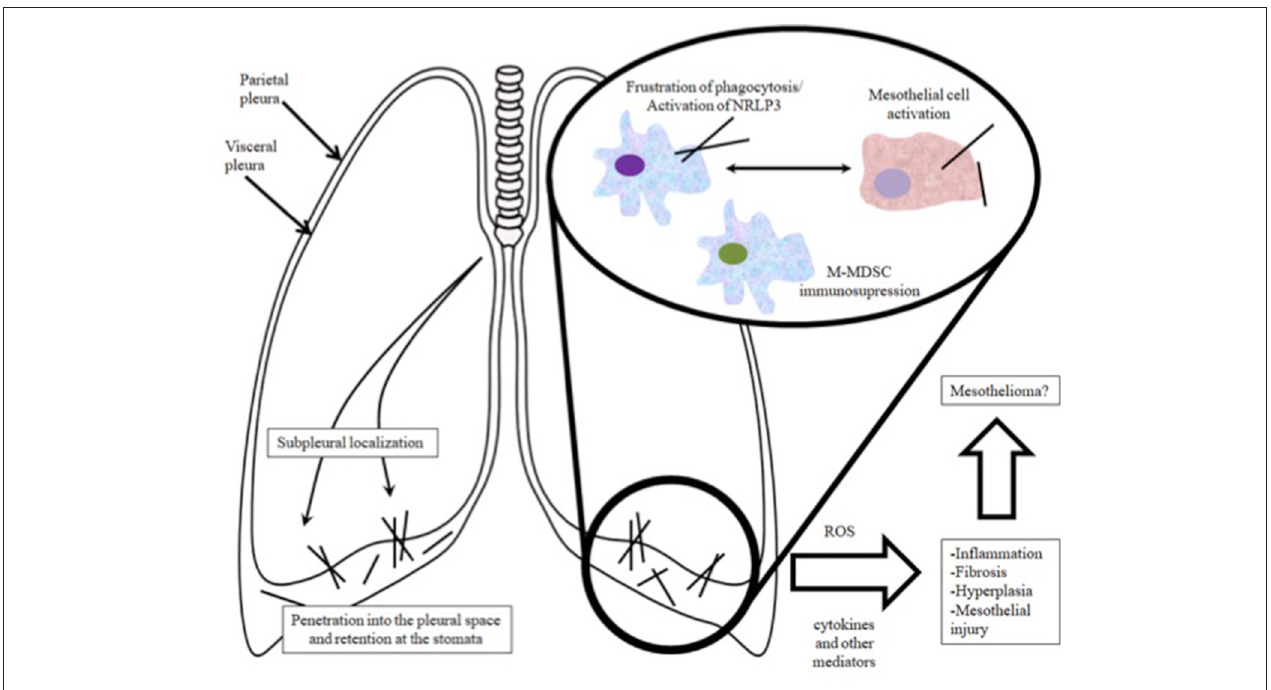
FIGURE 2 | Overview of the route of entry of CNTs into the pleural cavity and the associated pathophysiological